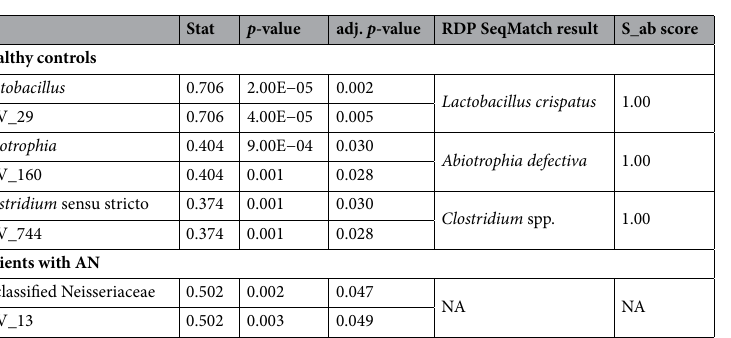
Table 2. Indicators at genus- and ASV-level with RDP SeqMatch results. Indicator species analysis applied using ‘indicspecies’ (version 1.7.9) with “r.g.” function and 99,999 permutations on a microbial core defined by ASVs classified to the genus-level that are present in at least 5% of all samples (see “Methods” section). p -values were adjusted for multiple testing according to Benjamini and Hochberg 94 . Representative 16S rRNA gene sequences were queried via Ribosomal Database Project SeqMatch (version 3). S_ab scores represent the number of unique 7-base oligomers shared between the query sequence and a given RDP sequence for both type- and non-type strains. The higher the S-ab score, the better the match. ASV amplicon sequent variant, RDP ribosomal database project, AN anorexia nervosa.